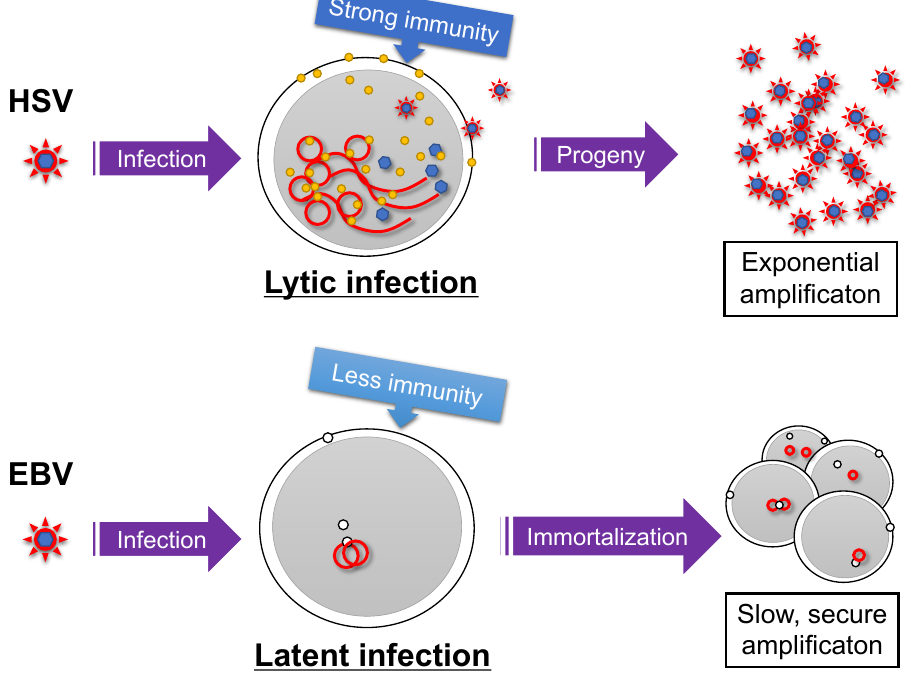
Figure 1. Survival strategies of herpesviruses. Infection of herpes simplex virus (HSV) causes lytic infection and the production of many progeny viruses, although the infected cells and virions may be targeted by the host immune reaction. Latent infection is maintained when the Epstein–Barr virus (EBV) infects a B cell, and the virus genome is amplified in synchronization with host cell amplification after immortalization. Red line indicates viral genome. Yellow and white circles represent viral lytic and latent gene products,